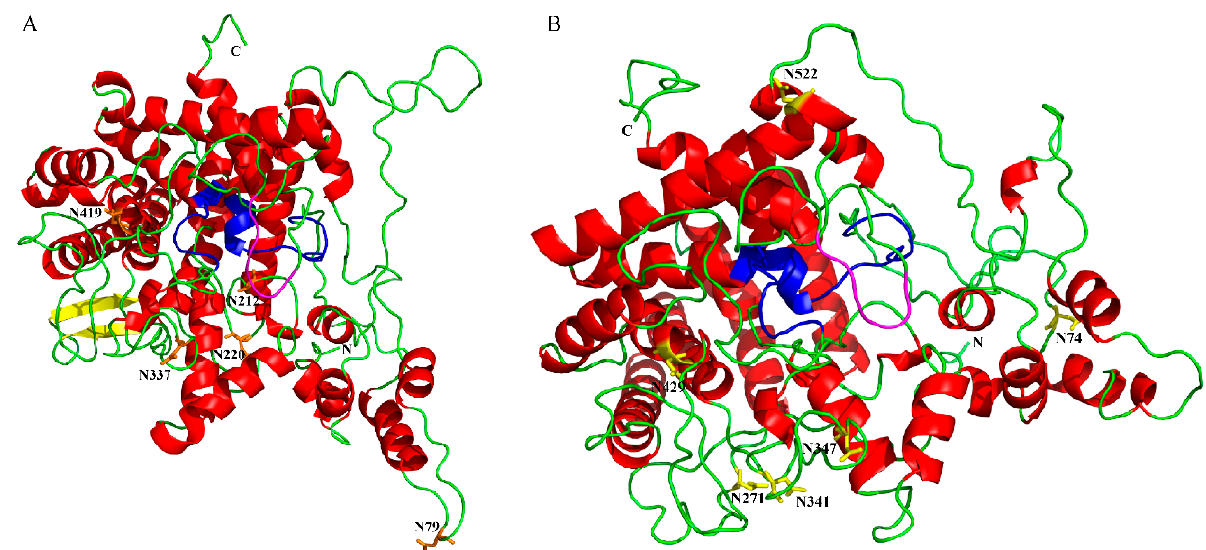
Figure 2. Three-dimensional model predictions generated by SWISS-MODEL homology modeling were performed using the crystal structure of periplasmic trehalase (PDB ID: 2wyn.1.A) as the template. ( A ) Sf Tre1 model; ( B ), Sf Tre2 model. α -helices are indicated in red. β -pleated sheets are indicated in yellow. Random coils are indicated in green. The signature motifs are indicated in blue. The glycine-rich region is indicated in purple.